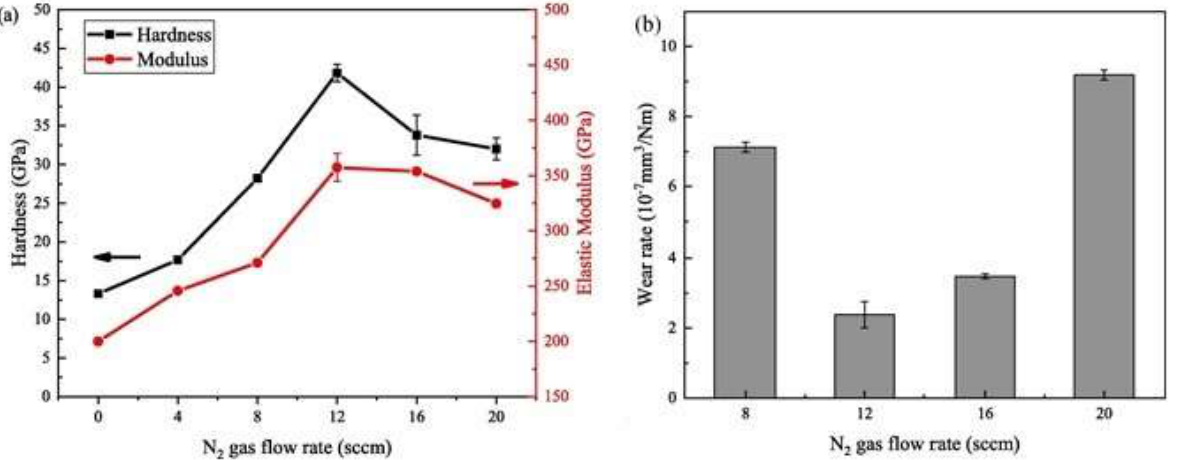
Figure 7. ( a ) Hardness and Young’s modulus, and ( b ) wear rates of the (AlCrTiVZr)N films as a function of the F N . Reproduced with permission from [49]. Copyright 2009, Elsevier.